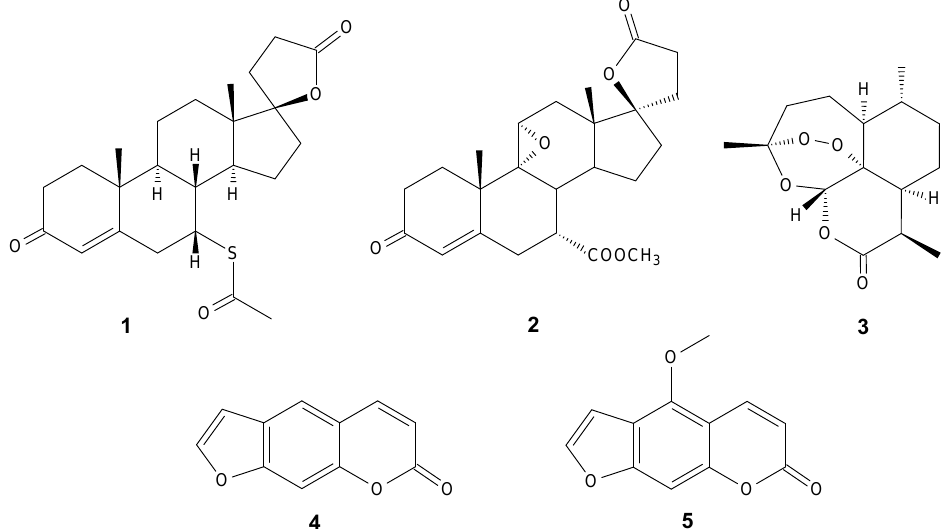
Figure 1. Spironolactone ( 1) , eplerenone ( 2 ), artemisinin ( 3 ), psoralen ( 4) , bergaptene ( 5 ).